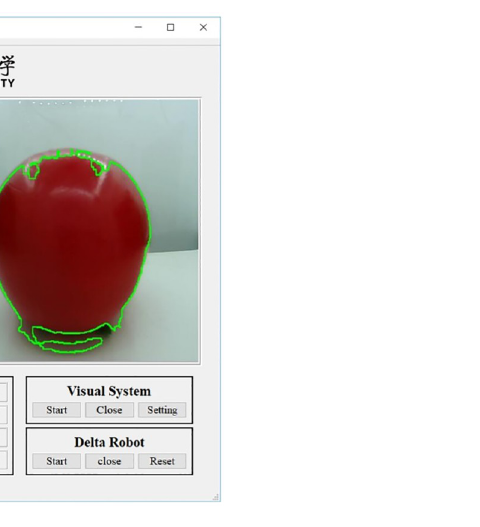
Fig 9. The operation interface of computer software.